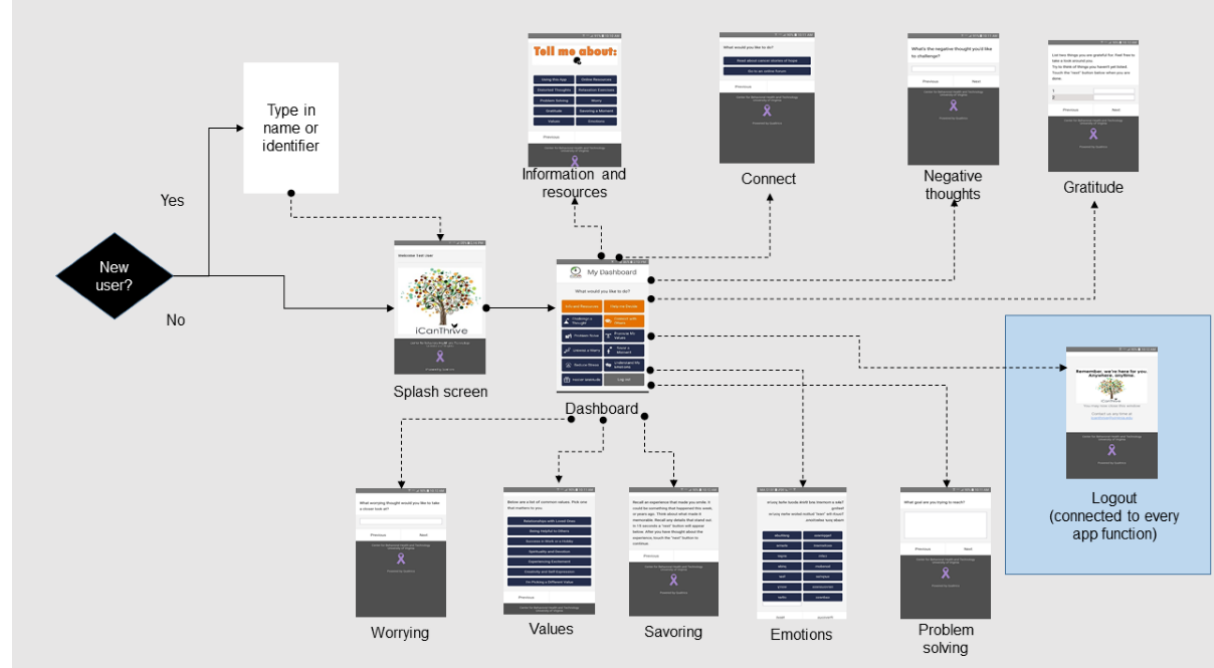
Figure 2. Example of a schematic that tracks how a user can navigate the app by showing how the front app pages and functions are